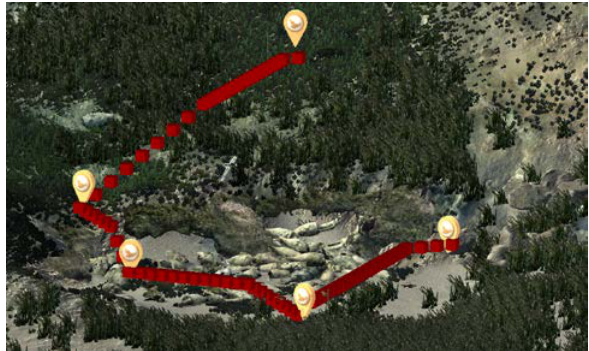
Figure 9. Pathfinding algorithm applied to the site of Cala